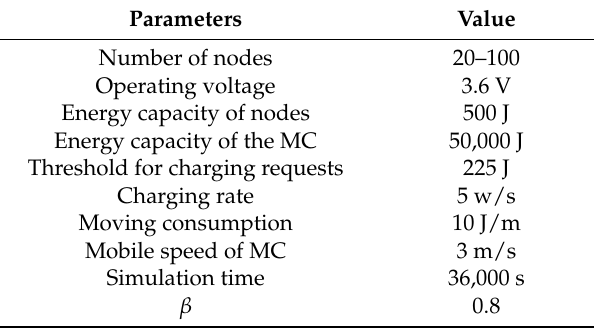
Table 3. Parameter